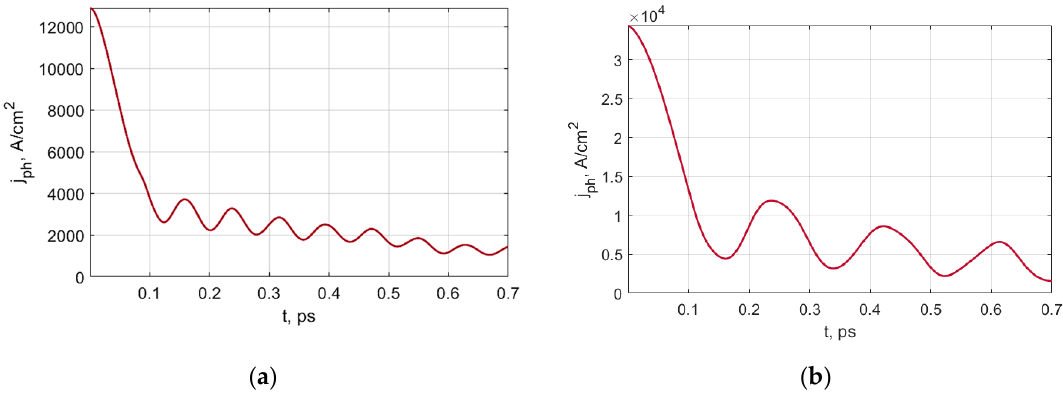
Figure 6. The photocurrent-density-versus-time characteristics for the photodetectors with controlled relocation of carrier density peaks—( a ) 10-nm LT/5-nm i -type/10-nm LT configuration (Figure 4); ( b ) 20-nm LT/10-nm i -type/20-nm LT configuration (Figures 3 and 5). The photocurrent flows through the device’s supply circuit during the back edge of a detected laser pulse.